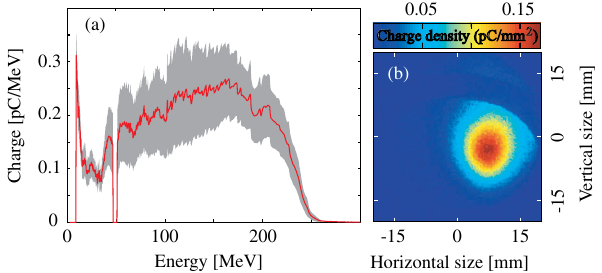
FIG. 8. (a) Reference e-beam spectrum for the activation mea- surement. The solid line shows the average spectrum, and the grey area shows the (cid:1) standard deviation. A total of 50 shots was taken. The normalized standard deviation of the total charge was found to be 32%. (b) Averaged e-beam profile measured by the Lanex during the activation. A total of 2700 shots was acquired, and the average charge was 37 pC = shot . The horizontal beam size in FWHM was measured to be 11.5 mm, and the vertical size was 13.7 mm.